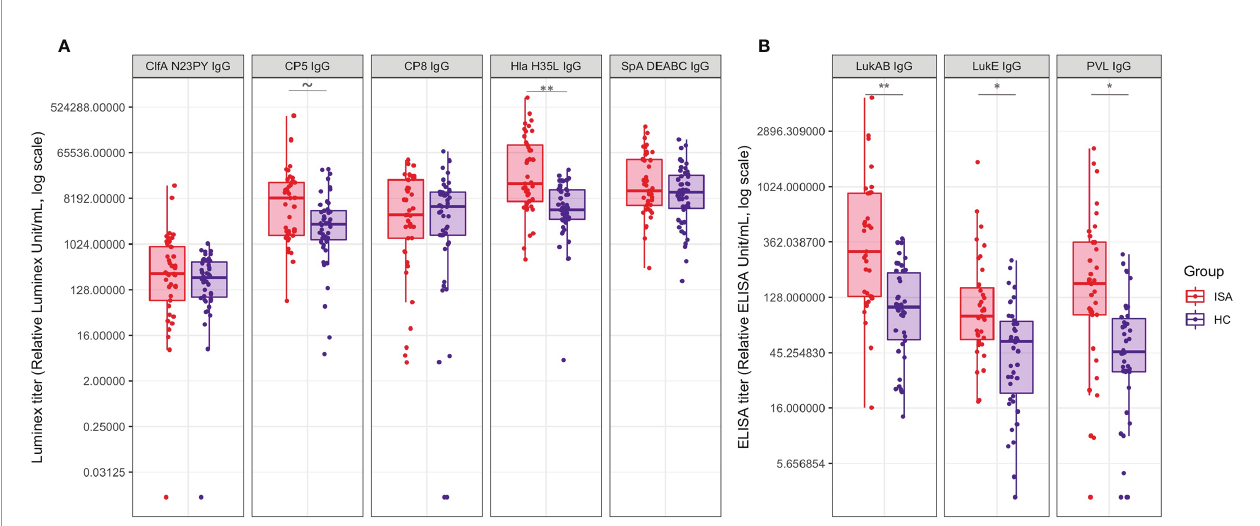
FIGURE 4 | Antibody titers against a panel of S. aureus virulence factors. Boxplot and scatterplot are reported to summarize IgG quanti fi cation levels by Luminex or ELISA. (A) reports the IgG values for ClfA, CP5, CP8, Hla and SpA, measured by Luminex analysis; (B) reports the IgG values for LukAB, LukED and PVL measured by ELISA. Samples in ISA group and HC are indicated in red and blue, respectively. Tilde and stars on top of the boxes report the level of signi fi cance of the Welch ’ s t-test p-values on the means: ~ 0.052, * < 0.05, ** < 0.001.